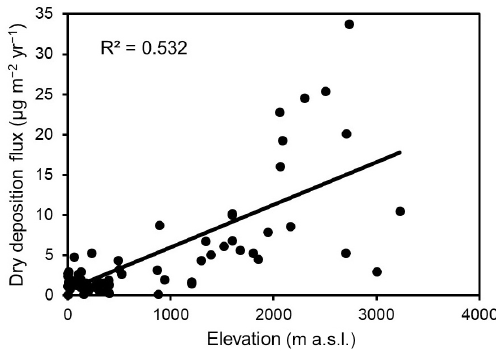
Figure 3. Relationship between the elevation and the GOM dry de- position flux.